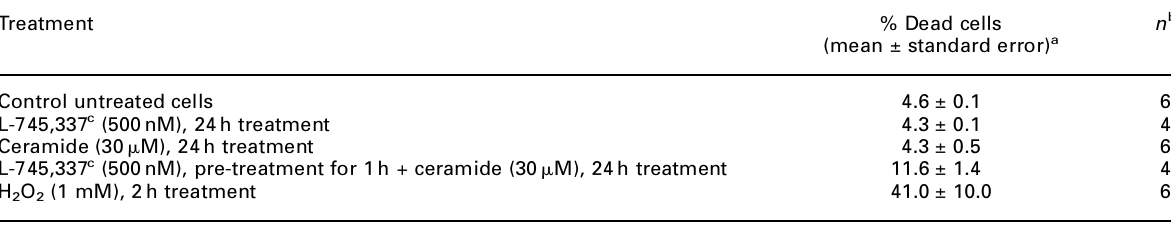
Table 3. Percentage of apoptosis in Mode-K cells Treatment